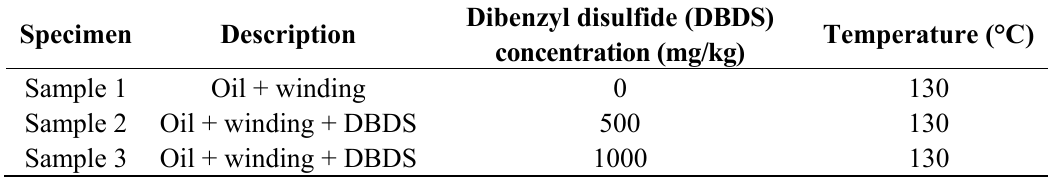
Table 2. Testing samples and condition of thermal aging tests.